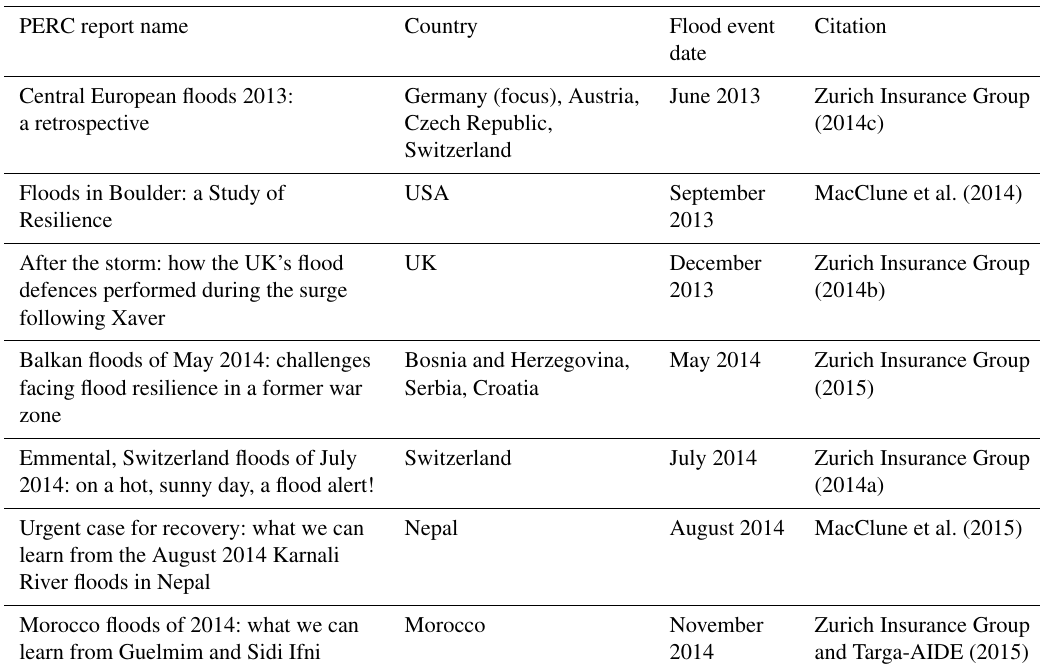
Table 1. PERC reports reviewed for the